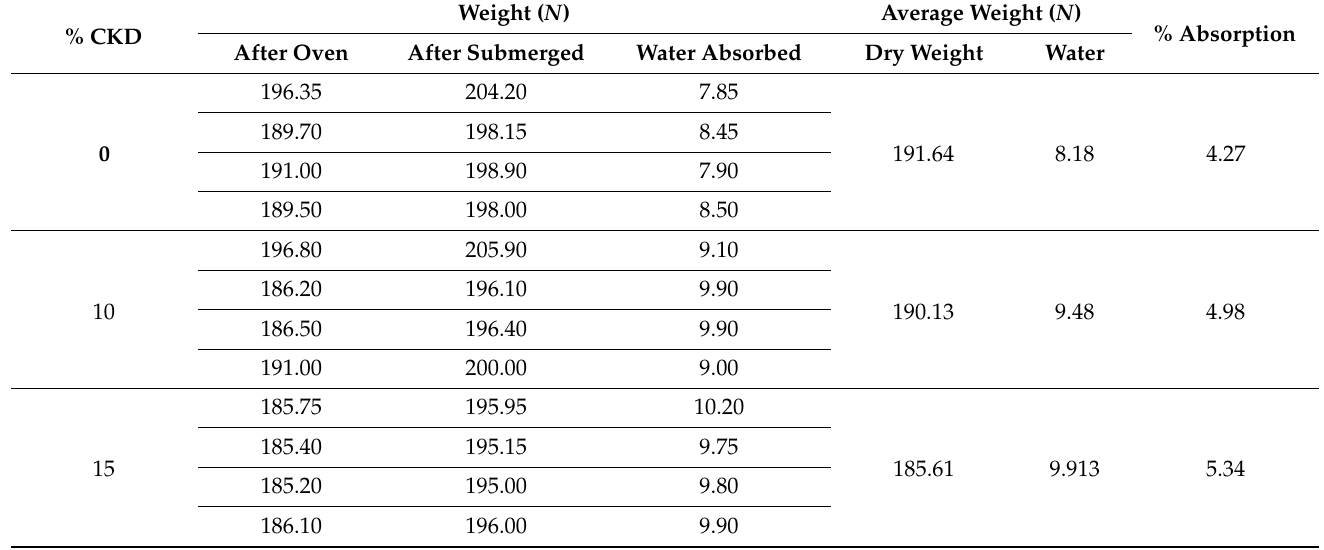
Table 7. Hollow blocks absorption